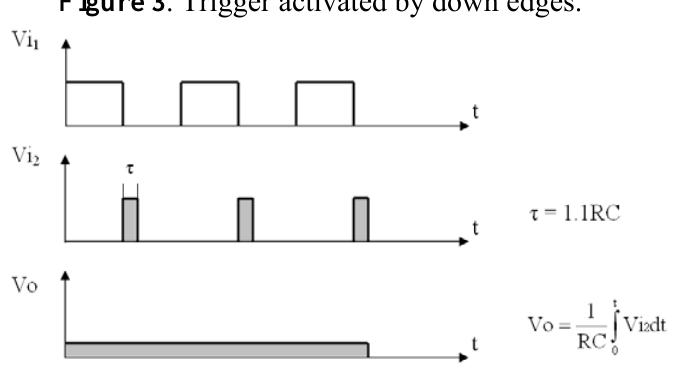
Figure 3 . Trigger activated by down edges.